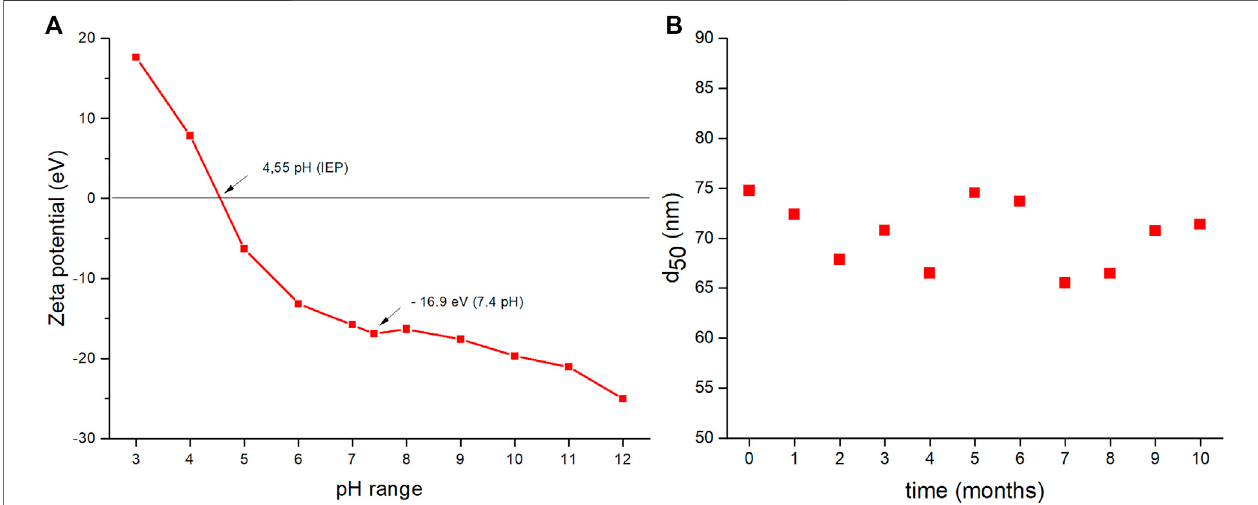
FIGURE 5 | (A) Dependence of zeta potential on pH, (B) long-term stability of BSA-capped CuS (dependence of d 50 value on time of storage).